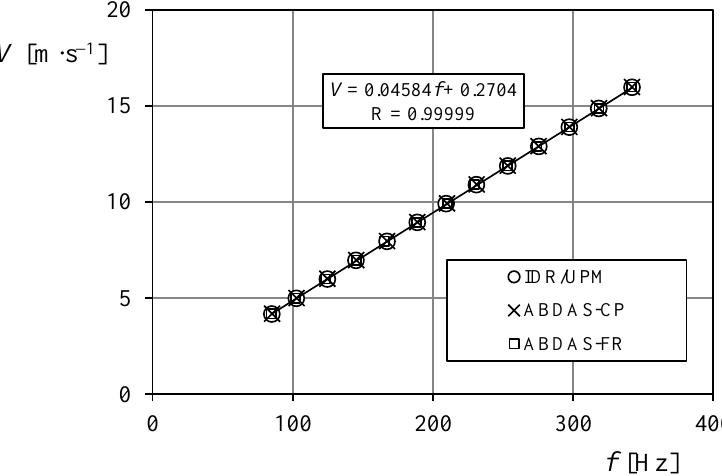
Figure 16. Fourier transforms of the recording data with ABDAS during the calibration process of Anemometer-2, at 4 and 16 m·s −1 .